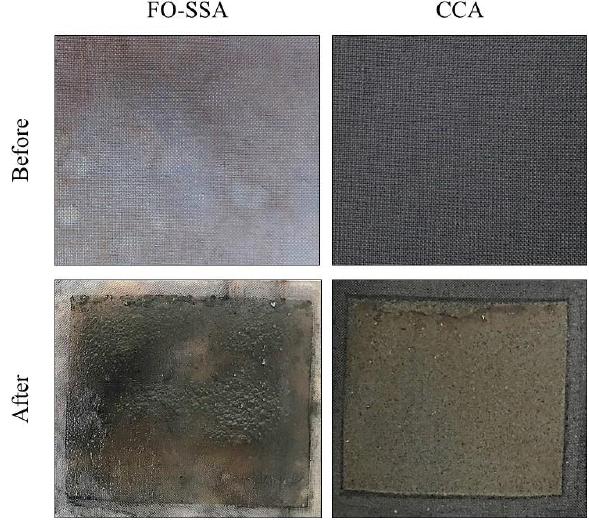
Figure 4. Images of the FO-SSA and CCA before and after culturing, showing biofilm attachment.